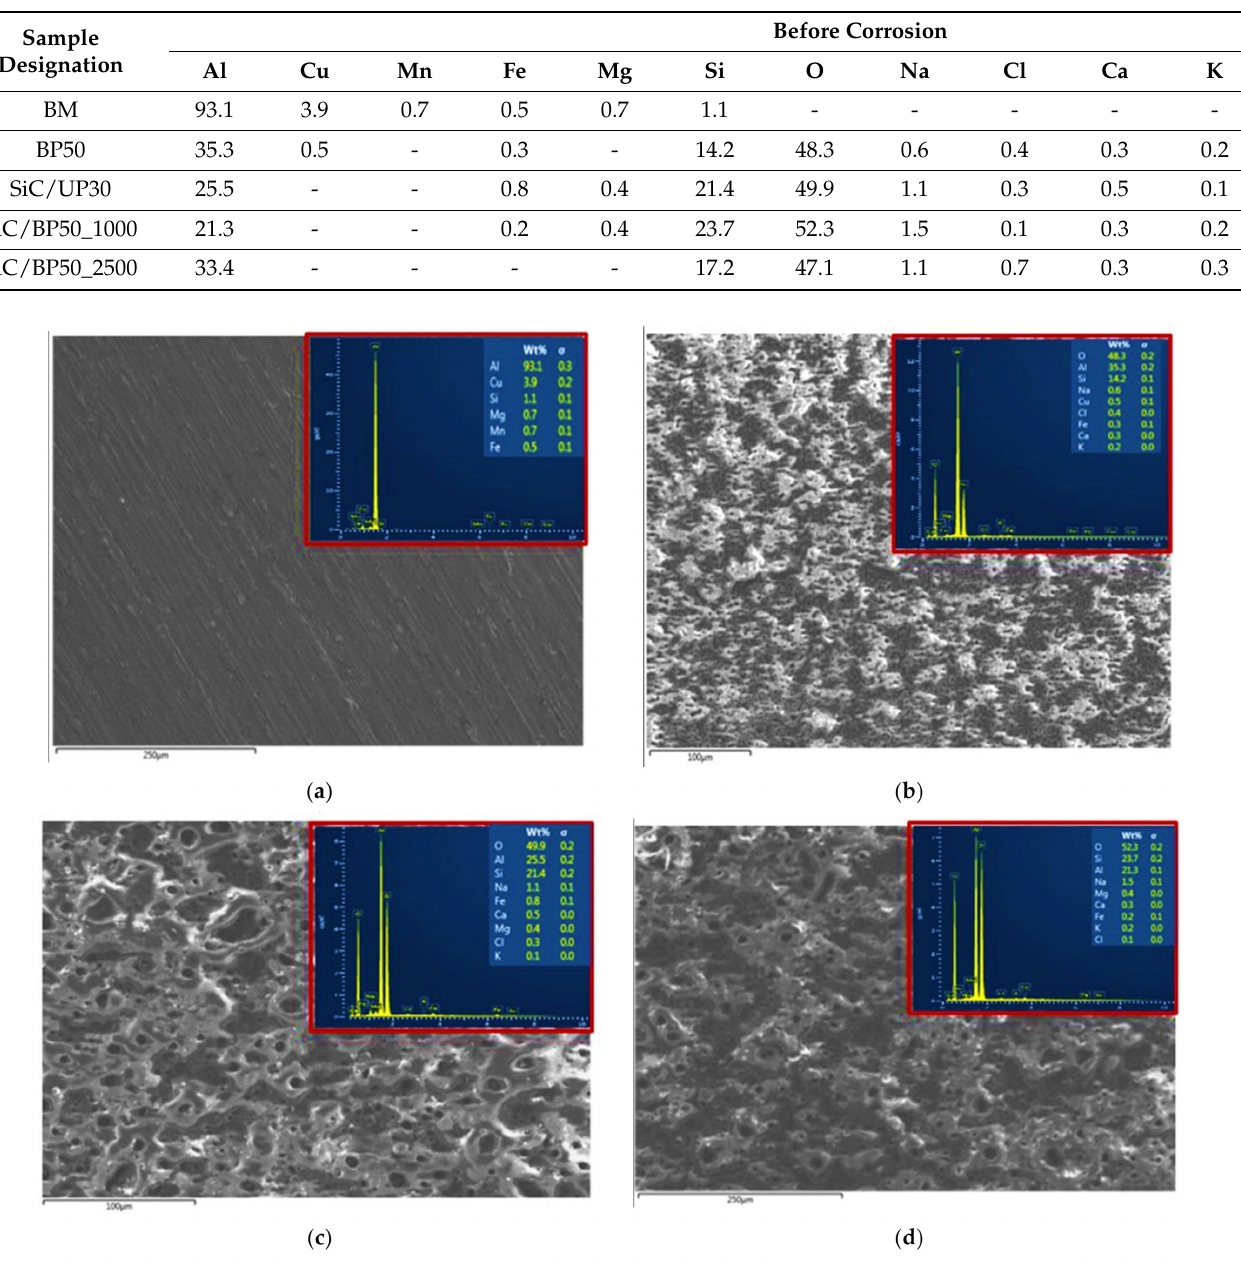
Table 2. EDS Chemical composition analysis of AA2014 samples under different conditions before corrosion (wt.%).